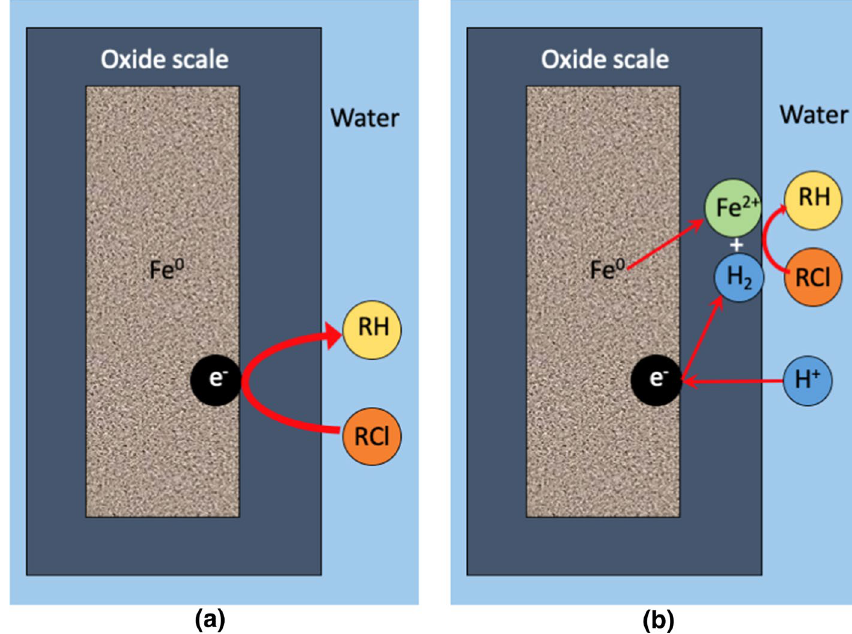
Fig. 1 Schematic representa- tion of possible mechanisms of contaminant (RCl) reduction by metallic iron (Fe 0 ): a elec- trochemical reaction (impos- sible) and b chemical